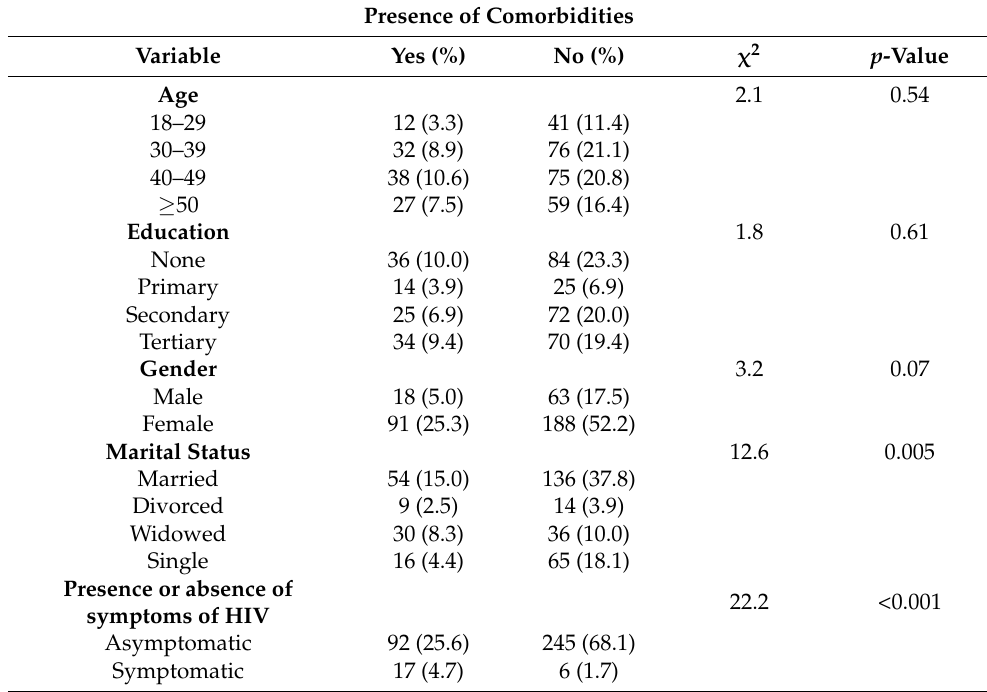
Table 4. Presence of comorbidities and associated